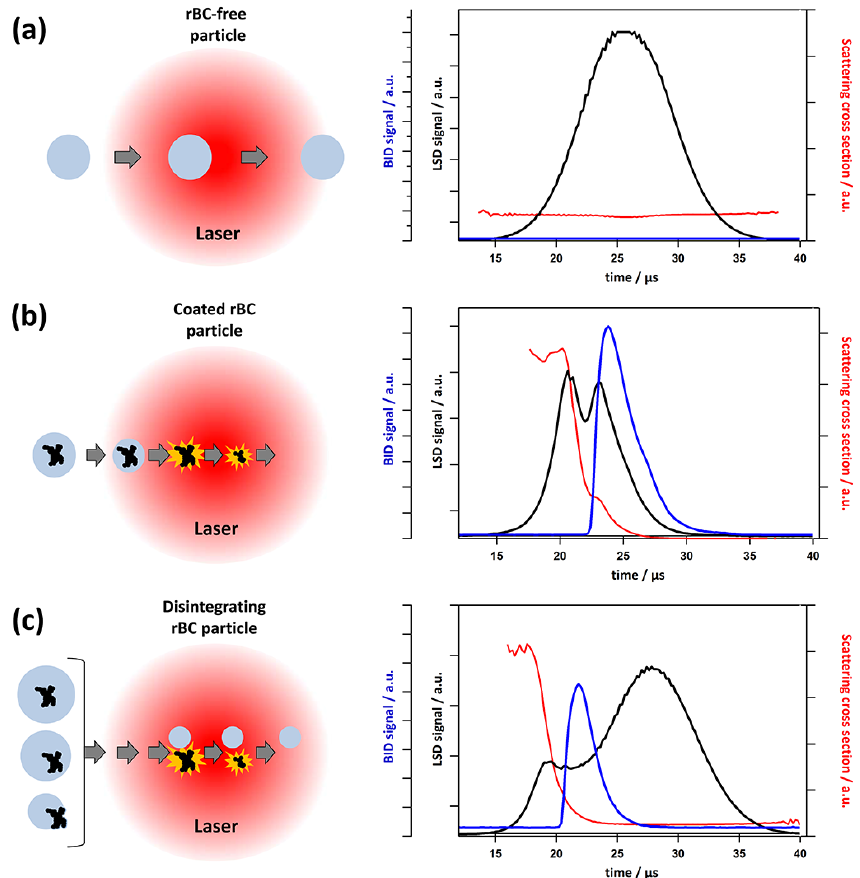
Figure 12. SP2 raw signals for selective particles with LSD signal (black) and BID signal (blue) and the scattering cross-section (red) for (a) – an rBC-free particle, (b) – a coated rBC particle and (c) – a disintegrating rBC particle. Schematics for the particle–laser interaction for each raw signal plot are shown on the left. For the disintegrating rBC particle in (c) several initial structures are possible: a very thickly coated rBC particle (top); a thickly coated particle with an eccentrically located rBC core (middle); an rBC particle located at the surface of an rBC-free particle (bottom). For depiction purposes the size of the schematically-shown particles (left) is enlarged compared to the laser diameter. The scattering cross-section was obtained by dividing the scattering signal by the laser intensity profile. The incandescence is indicated by yellow